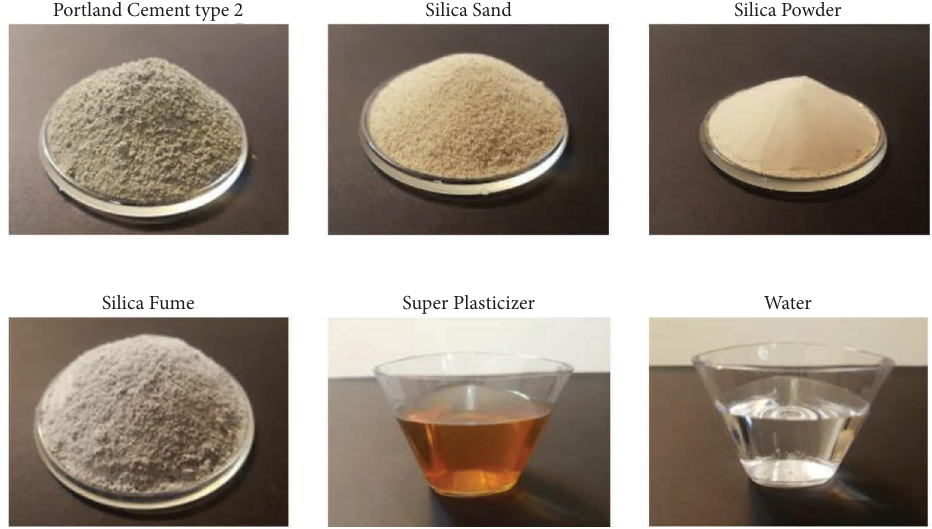
Figure 1: All the materials used in this research.